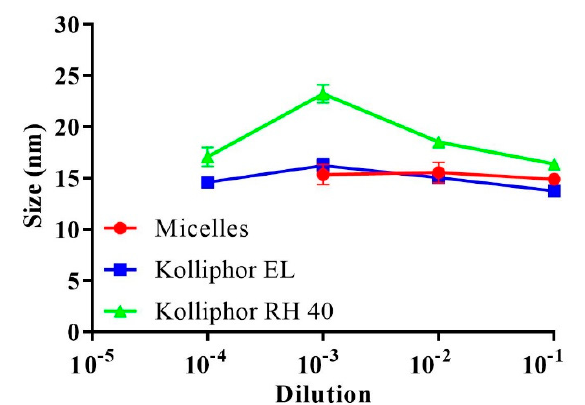
Figure 2. Average droplet size of the micelles and the surfactants Kolliphor EL and Kolliphor RH 40 after 0.1–0.0001 dilutions in 0.1 M phosphate buffer (pH 6.8) at 37 ◦ C. Indicated values are the means ± SD ( n ≥